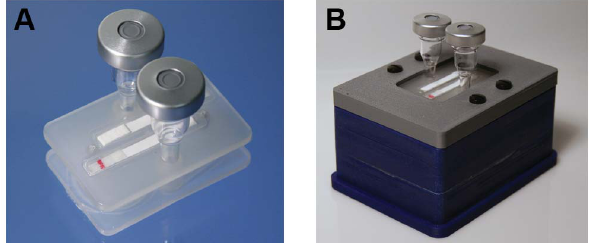
Figure 2. System components. (a) Top side of cartridge: lateral flow strips are sealed inside the grooves forming the lateral flow strip pouches, and electrolytic chambers are press-fit in place. (b) Heater with cartridge secured in place, prior to test execution. (a) and (b) The red line on the NALF strips represents the colored microspheres immobi- lized on the treated conjugate